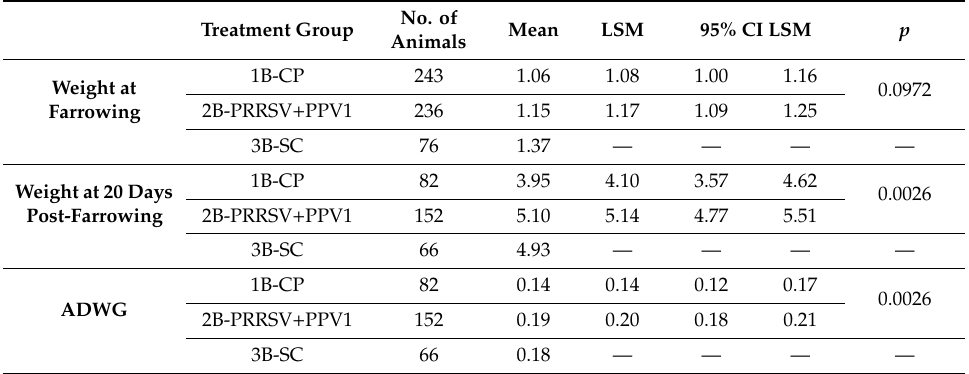
Table 4. Body weight and average daily weight gain (ADWG) (kg) of piglets. Least squares means (LSM) of the groups and di ff erences between LSM with 95% CI were derived from the analysis of variance (ANOVA). The weight at farrowing was used as a covariate for the corresponding analysis of body weight at day 20 post-farrowing and